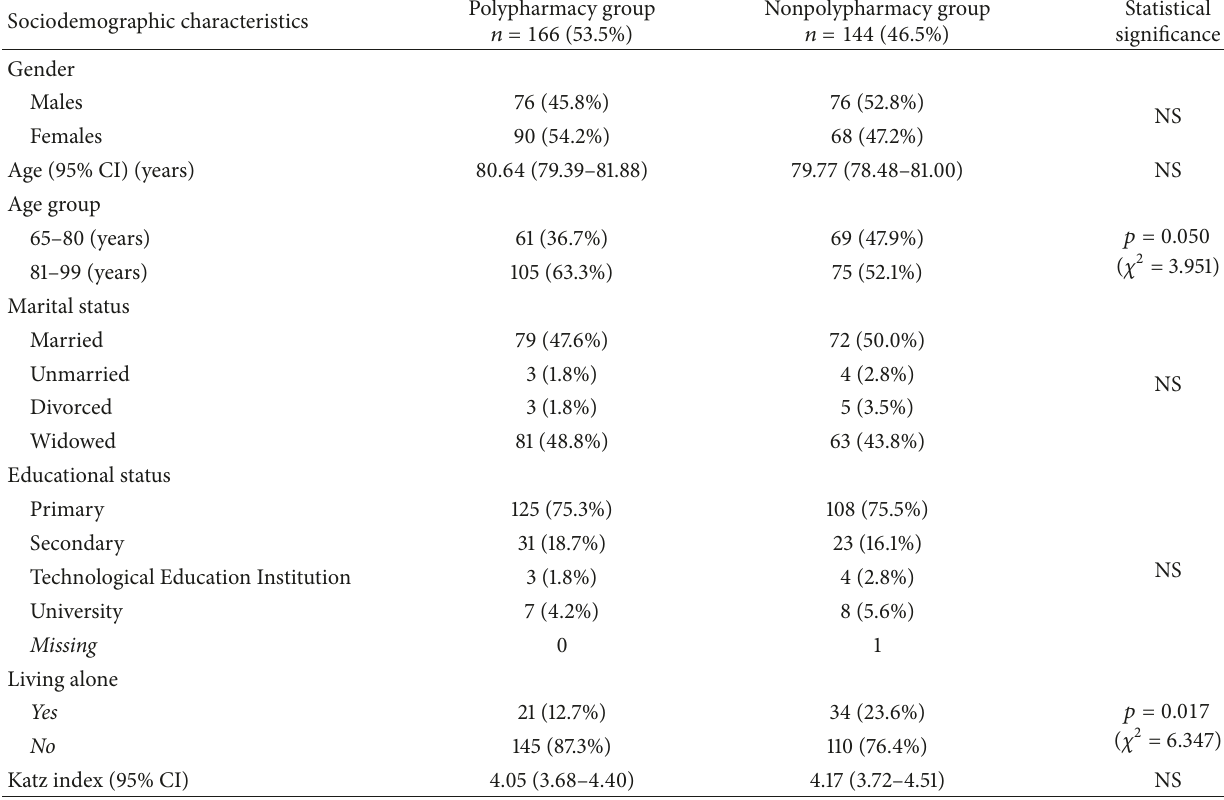
Table 1: Comparison of sociodemographic characteristics between patients belonging to polypharmacy and nonpolypharmacy